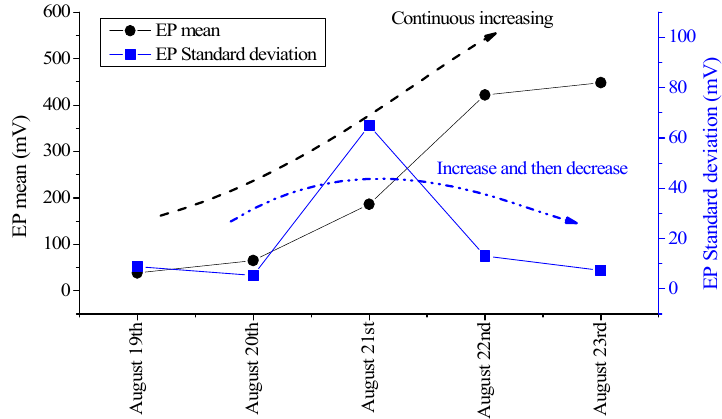
Figure 13. Response results of EP signals before and after stress abnormality occurrence.